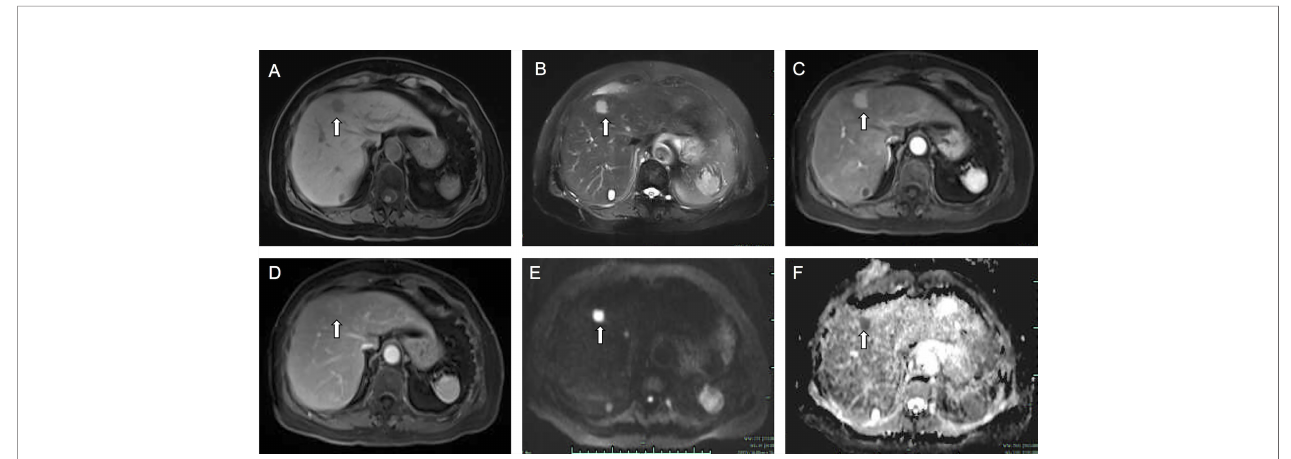
FIGURE 2 | Fat-saturated T1-weighted image (A) showed a hypointense lesion measuring 17 mm in the segment 4 of the liver. The lesion showed hyperintensity on T2-weighted image (B) . On enhanced T1-weighted images, the lesion showed obvious enhancement in arterial phase (C) , and in portal phase (D) the lesion showed